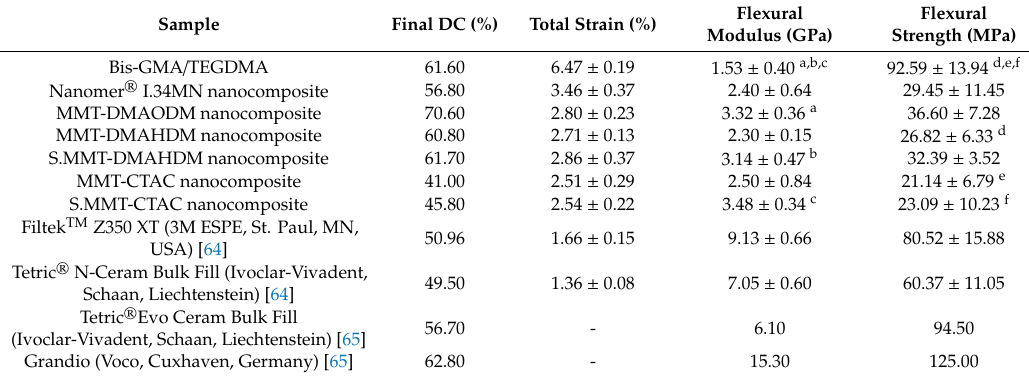
Table 2. Experimental values concerning curing kinetics, polymerization shrinkage and mechanical properties of pure 2,2-Bis[p-(2 (cid:48) -hydroxy-3 (cid:48) - methacryloxypropoxy)phenylene]propane / triethylene glycol dimethacrylate(Bis-GMA / TEGDMA) resin and dental nanocomposite resins.For flexural modulus and strength mean values, the groups with the same superscript letters exhibit statistically significant di ff erences (p < 0.001). Literature data for typical commercially available dental resins are also included